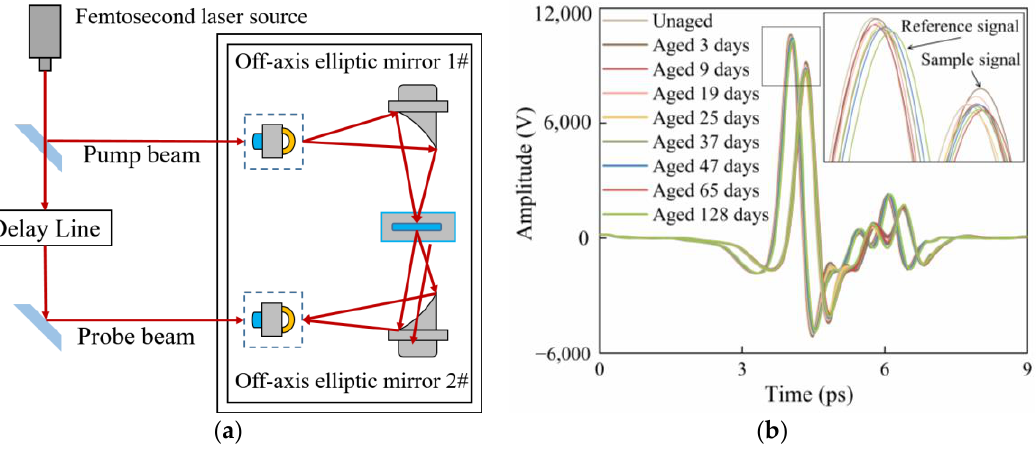
Figure 2. ( a ) Schematic diagram of transmission THz-TDS system. ( b ) Terahertz time-domain spectra of air reference and insulating paper with different aging days.